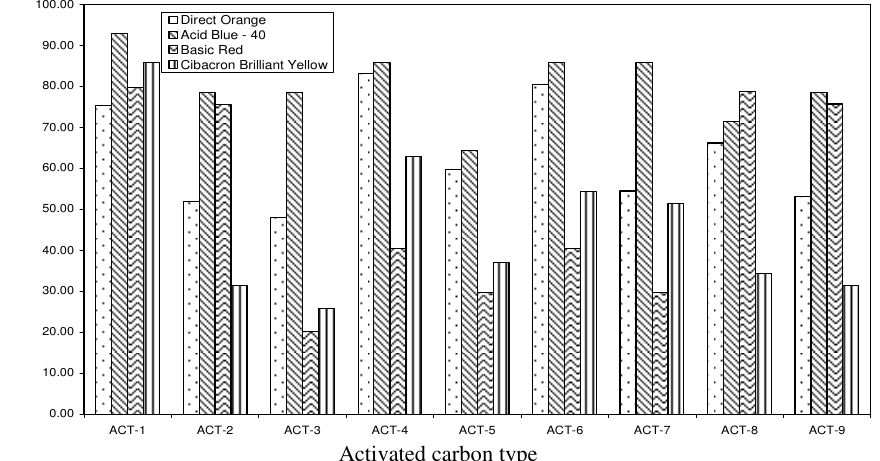
Figure 1 . Percentage of dye removal by activated carbon